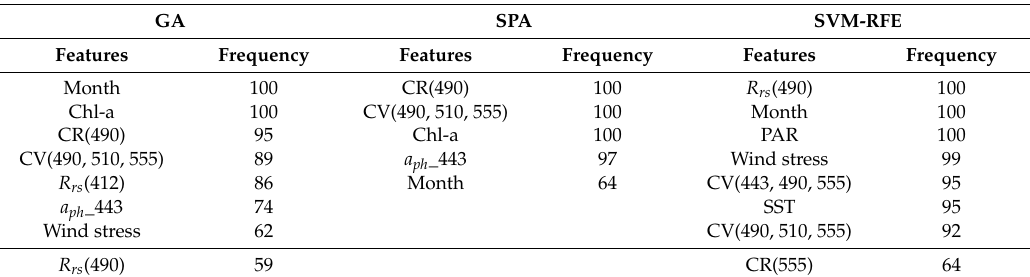
Table 5. Sensitive features for retrieving nanoplankton size fractions selected, respectively, by genetic algorithm (GA), successive projection algorithm (SPM) and recursive feature elimination based on support vector machine regression (SVM-RFE).